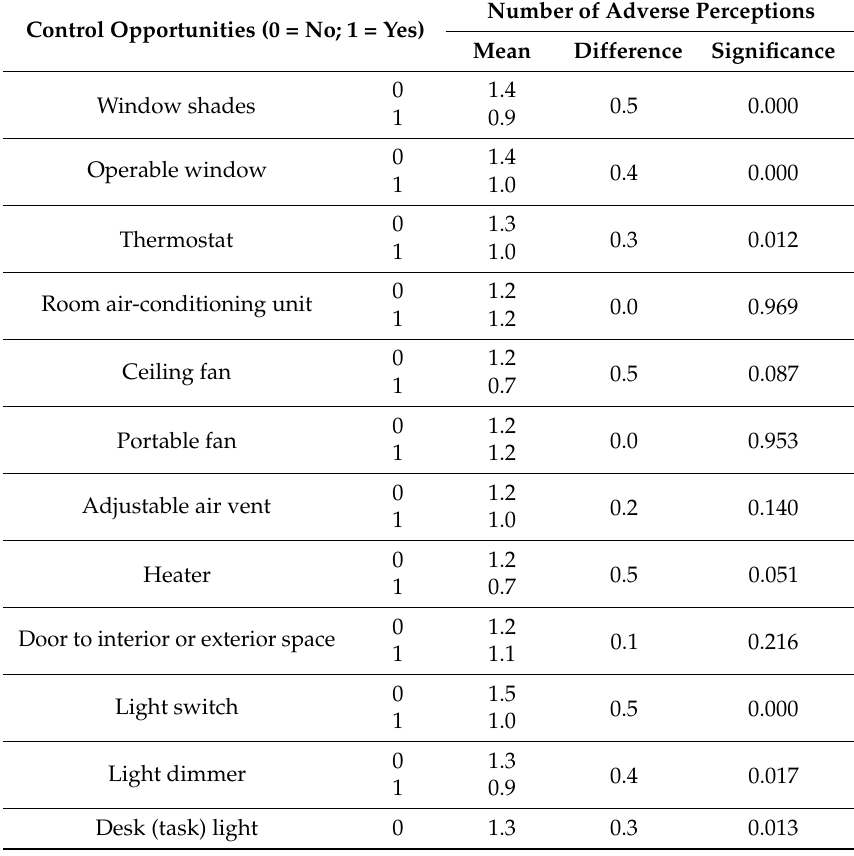
Table 7. Control opportunities and adverse